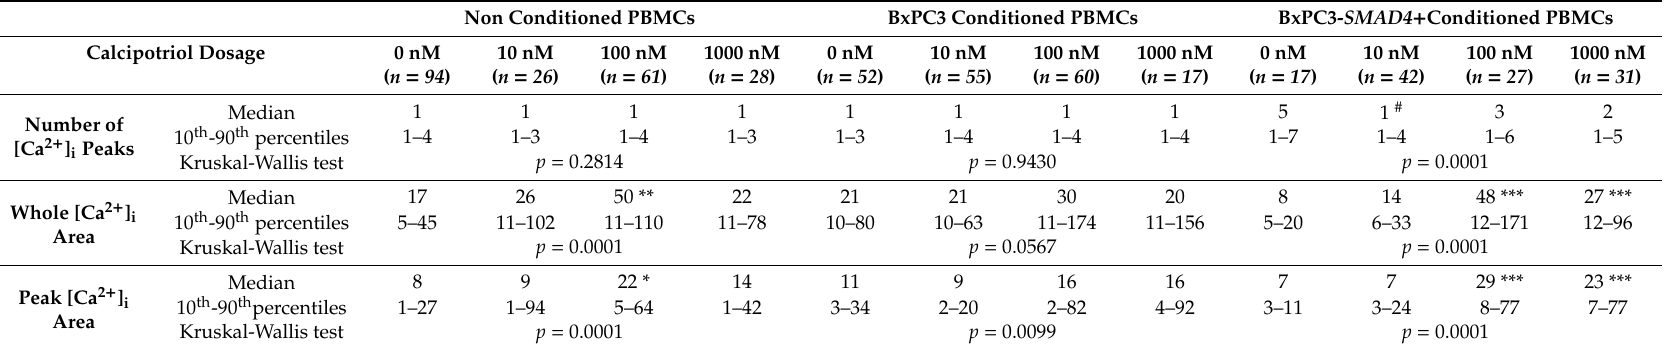
Table 3. The e ff ects of PDAC and calcipotriol on the intracellular calcium [Ca 2 + ] i of PBMCs. PBMCs were cultured in non-conditioned medium, BxPC3 or BxPC3- SMAD4 + conditioned media for 3 days in the absence (0 nM) or presence of increasing dosages of calcipotriol (10, 100, 1000 nM). Data are from four independent experiments, the total number of single cells analyzed being reported in